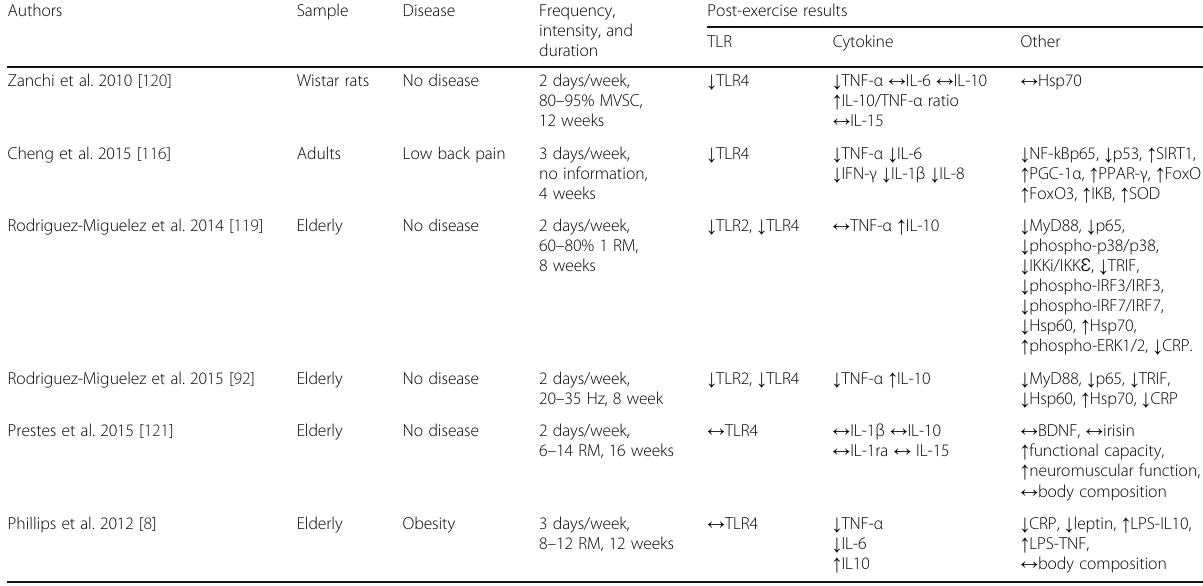
Table 4 Modulation of TLR2 and TLR4 after chronic resistance exercise